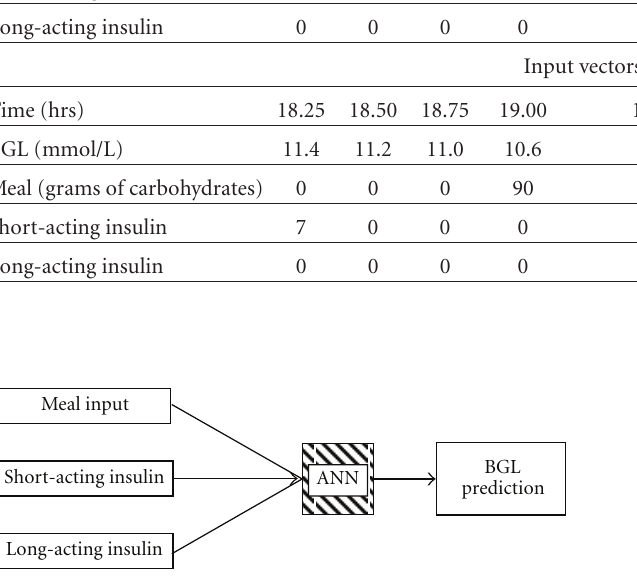
Figure 2: Schematic of inputs for long-term prediction ANN training.